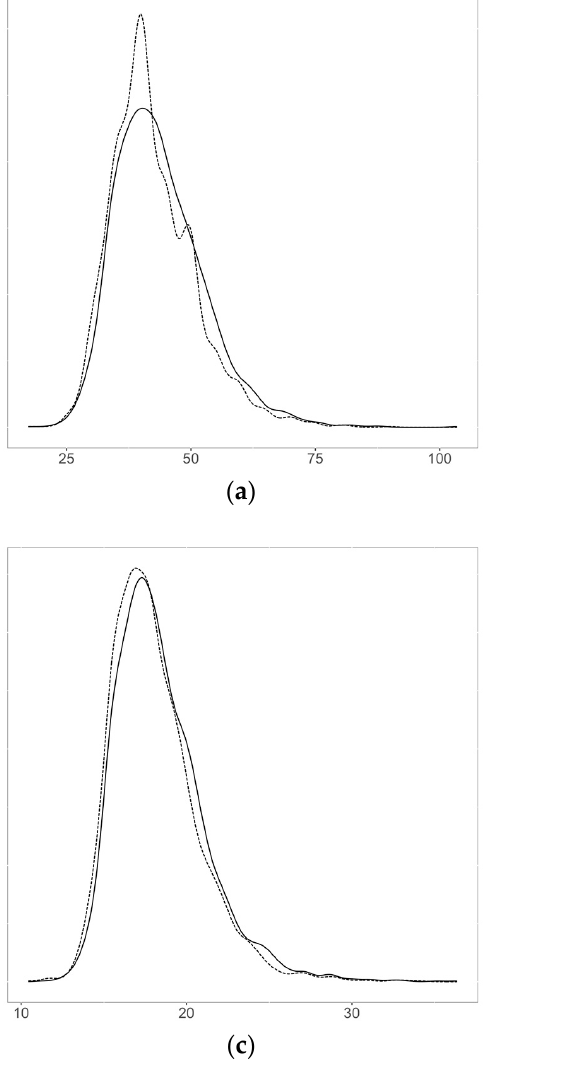
Figure 1. Distribution of ( a ) weight (kg), ( b ) height (cm), ( c ) BMI (kg/m 2 ), and ( d ) BMI z-score (continuous line: measured, dashed line: self-reported). Table 2. Self-reported and measured weight, height, BMI and BMI z-scores, mean, mean difference, and